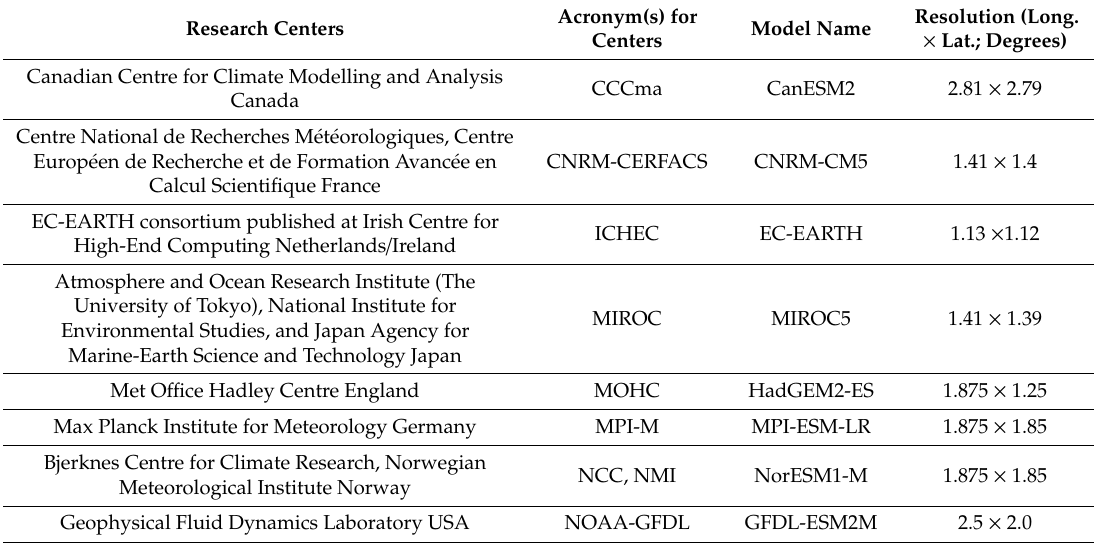
Table 2. Presentation of global climate models selected for the